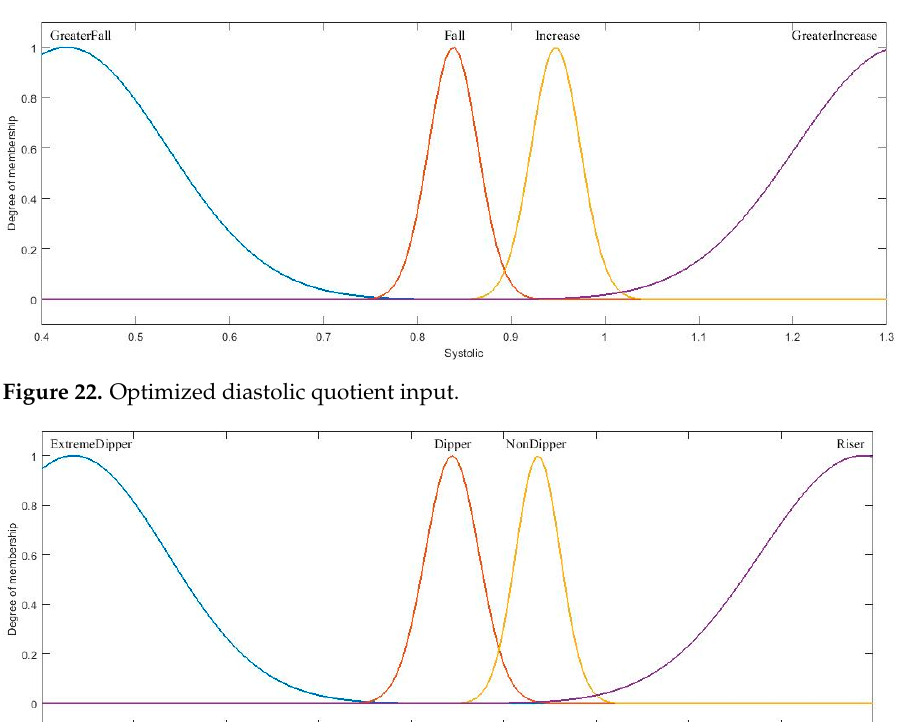
Figure 21. Optimized systolic quotient input.